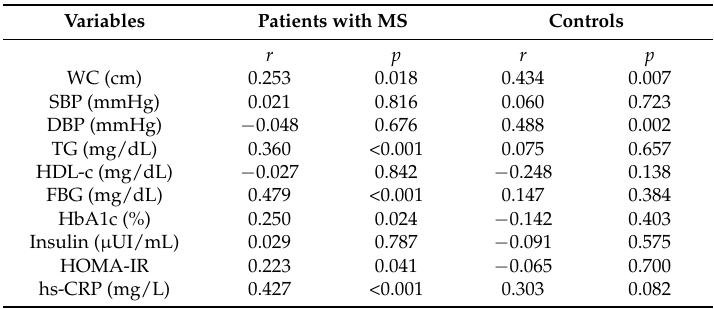
Table 2. Correlations between 24-h urinary zinc excretion and cardiometabolic risk factors. Variables Patients with